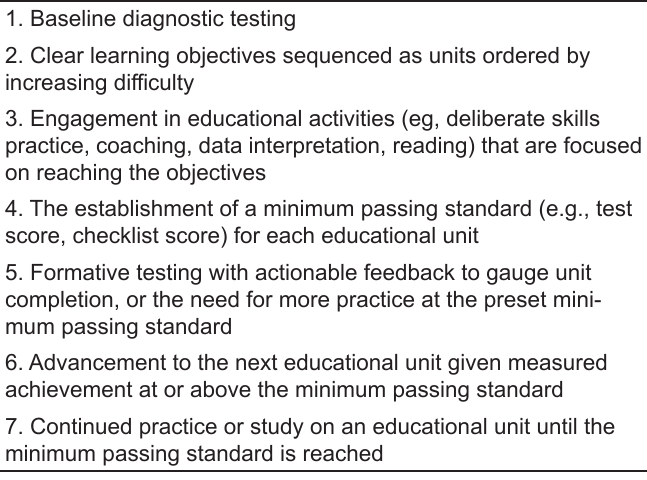
Table 1. Seven features of a mastery learning bundle.